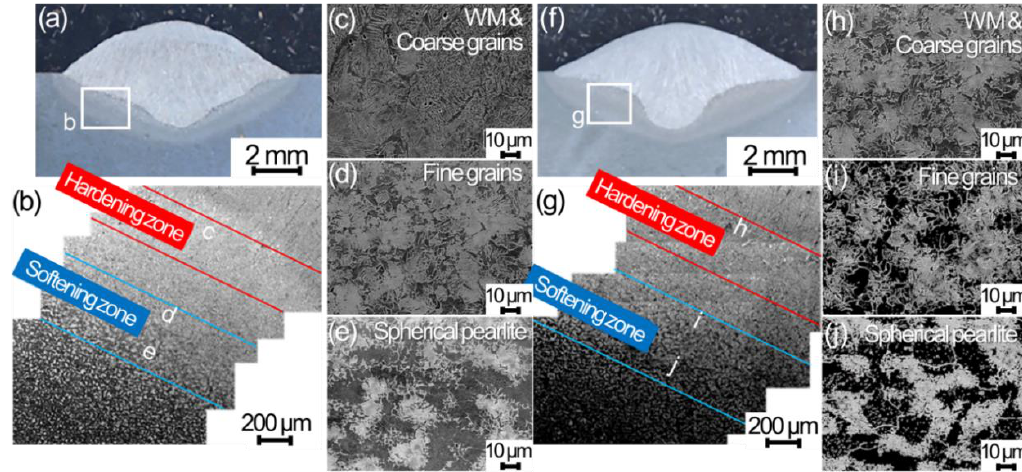
Figure 4. Cross-sectional scanning electron microscope (SEM) images for TP-GMAW specimens at 1.2 m/min ( a–c ) w/ and ( f–j ) w/o sine vibration (F = 250 Hz, G = 1.2 m/s 2 and T = 30 s). 1.2 m / min ( a – c ) w / and ( f – j ) w / o sine vibration (F = 250 Hz, G = 1.2 m / s 2 and T = 30 s).